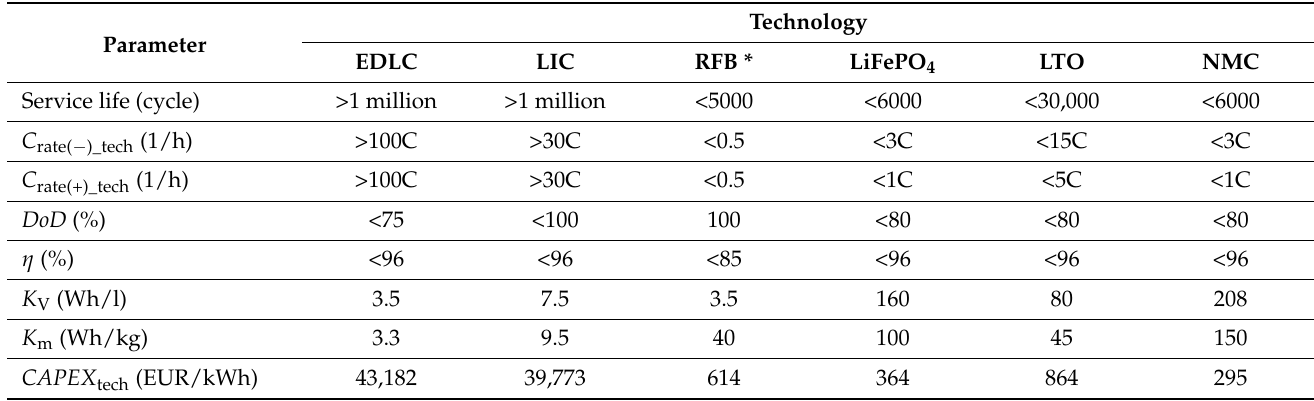
Table 8. Selected parameters of ES